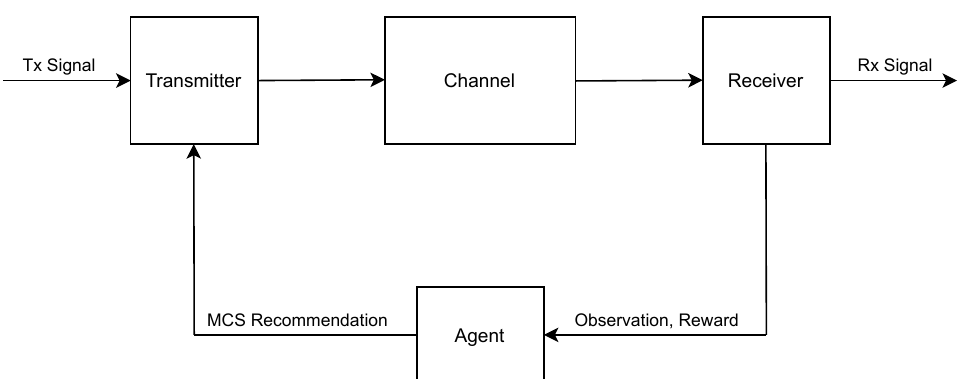
Figure 2. The basic concept of the presented approach. An agent observes the state and recom- mends an action. Finally, the environment provides a reward, depending on the success of the previous